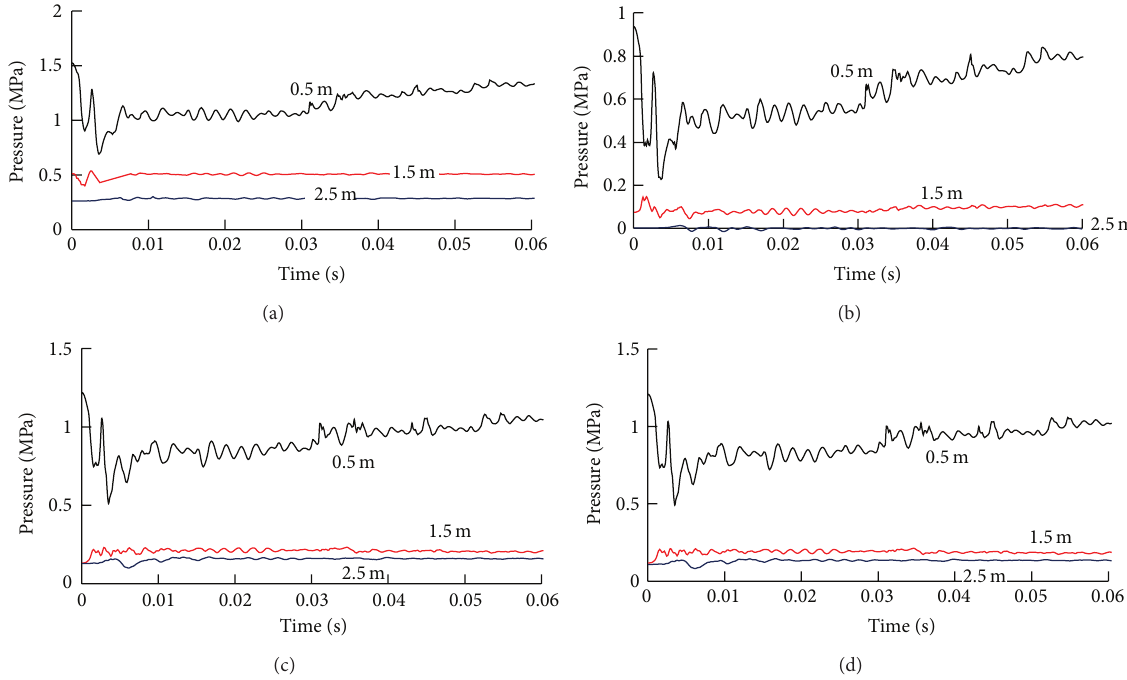
Figure 8: Dynamic response curves for the surrounding rock mass; (a) vertical stress in the roof, (b) vertical stress in the floor, (c) horizontal stress in the right wall, and (d) horizontal stress in the left